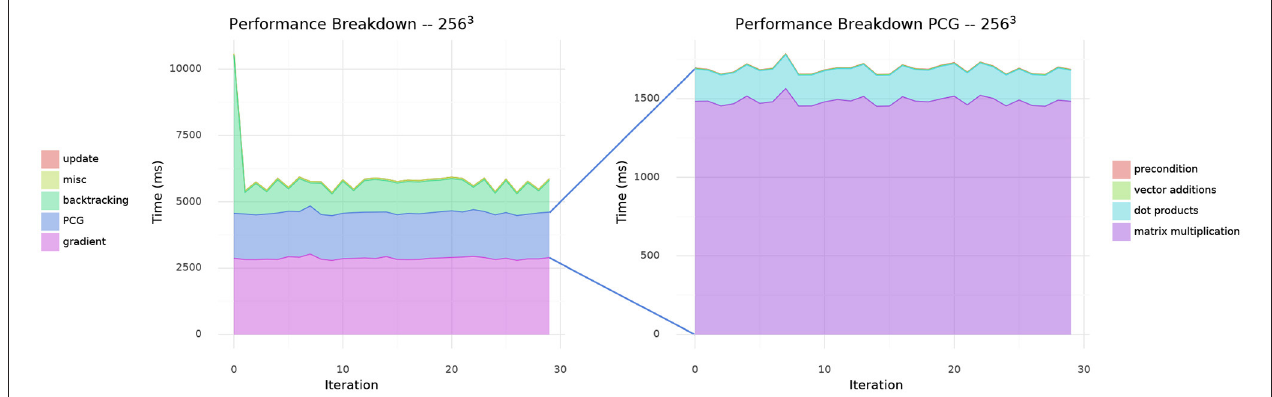
FIGURE 7 | Performance breakdown of used CUDA kernels. The PCG algorithm is comprised of several kernels whose individual times are shown to the right.